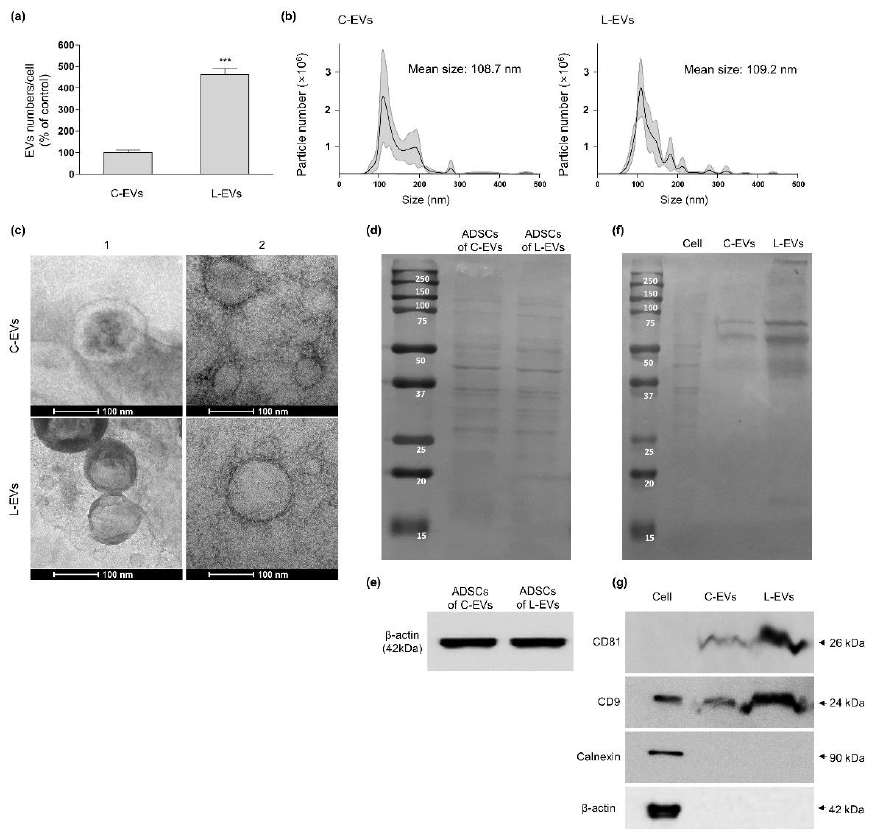
Figure 2. Productivity and morphologic characteristics of L-EVs and C-EVs. L-EVs and C-EVs were separated from their respective hADSC-CMs. ( a , b ) The number and size of EVs detected by NTA. ( a ) The number of EVs was divided by the number of originating hADSCs and presented as relative values compared to C-EVs (unpaired t-test, n = 5, p < 0.0001). Error bars represent ±SD, *** p < 0.001 were calculated versus the C-EVs. ( b ) Black solid lines: mean size of EVs; gray area: ±SD. ( c ) Repre- sentative TEM images of the EVs. Both C-EVs and L-EVs were negatively stained. Scale bars = 100 nm. ( d ) Same numbers of ADSCs were cultured in media containing 10 µg/mL of hLF and 1 mM of CaCl 2 (ADSCs of L-EVs) or in media with none of the aforementioned additives (ADSCs of C-EVs), respectively. The result was obtained by ponceau S stain of ADSCs. ( e ) β -actin level of ADSCs de- tected by western blot. ( f ) Ponceau S stain of EVs. ( g ) CD81, CD9, calnexin, and β -actin levels of EVs were measured by western blot. The markers and protein compositions were measured in C-EVs and L-EVs lysates derived from the same number of hADSC. The results for CD81 and CD9 were obtained individually through two independent experiments. For calnexin, hADSC were used for positive control.